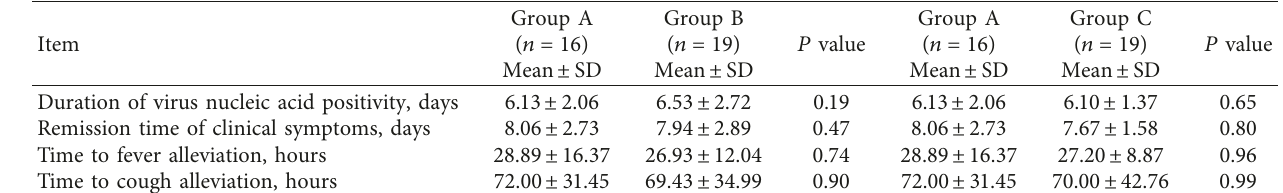
Table 3: Clinical efficacy of three groups.